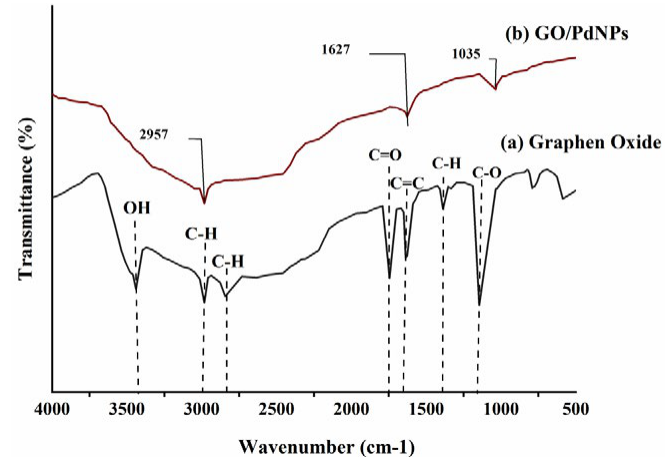
Fig. 4. FTIR spectra of GO (a) and GO-Pd NPs (b).